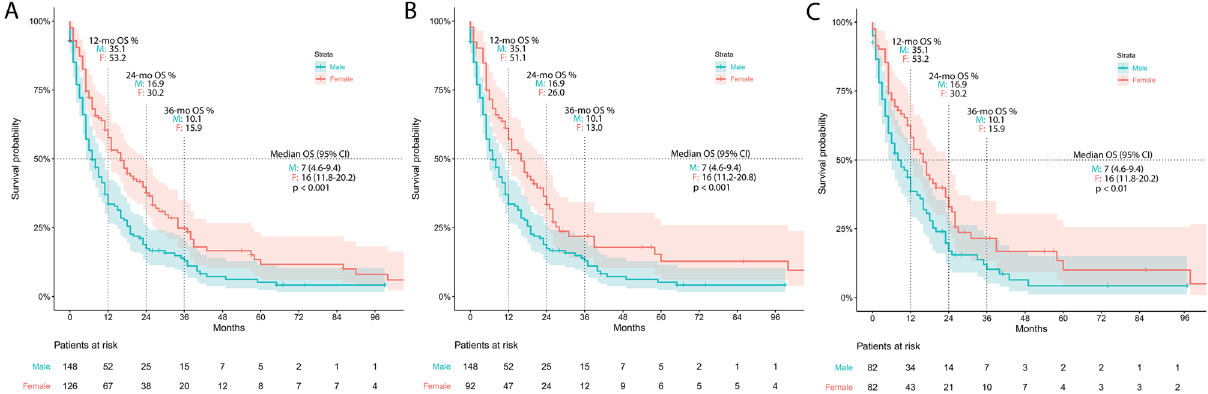
Figure 3. Kaplan–Meier analysis of survival by sex with ( A ) and without ( B ) inclusion of breast cancer patients, and after propensity score matching for prognostic factors other than sex ( C ).